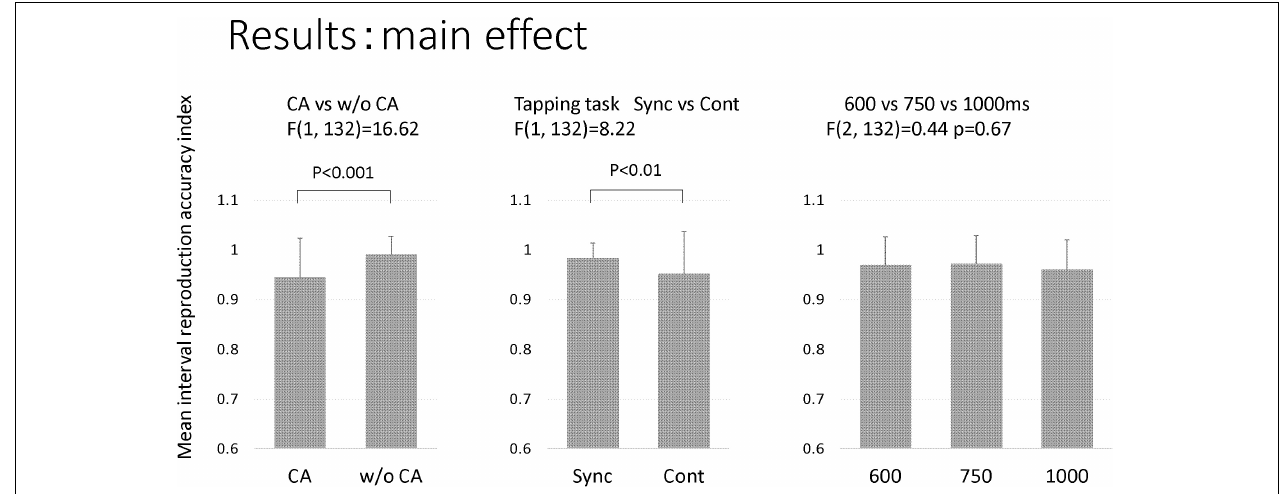
FIGURE 3 | The main effect of the factors. The factors included groups (CA, constructional apraxia; w/o CA, without constructional apraxia), tapping tasks (Sync, synchronization; Cont, continuation), and inter-stimulus intervals (600 ms, 750 ms, and 100 ms). Error bars indicate standard deviations.